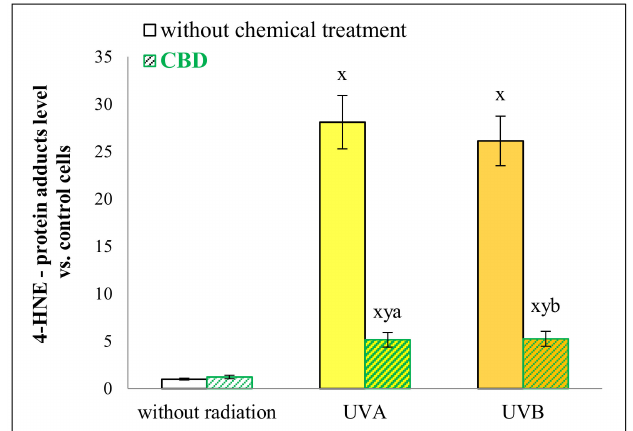
Figure 7. The level of 4-hydroxynonenal (4-HNE)-protein adducts in keratinocytes following UVA (30 J/cm 2 ) or UVB (60 mJ/cm 2 ) radiation and treated with cannabidiol (CBD, 4 µ M) in a three- dimensional culture model. x: statistically significant differences vs. non-treated cells, p < 0.05; y: statistically significant differences vs. CBD-treated cells, p < 0.05; a: statistically significant differ- ences vs. UVA-irradiated cells, p < 0.05; b: statistically significant differences vs. UVB-irradiated cells, p < 0.05.